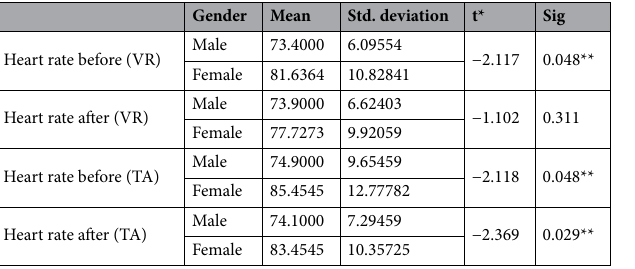
Table 4. Differences in heart rate according to gender for each procedure. **Differences are significant at p <